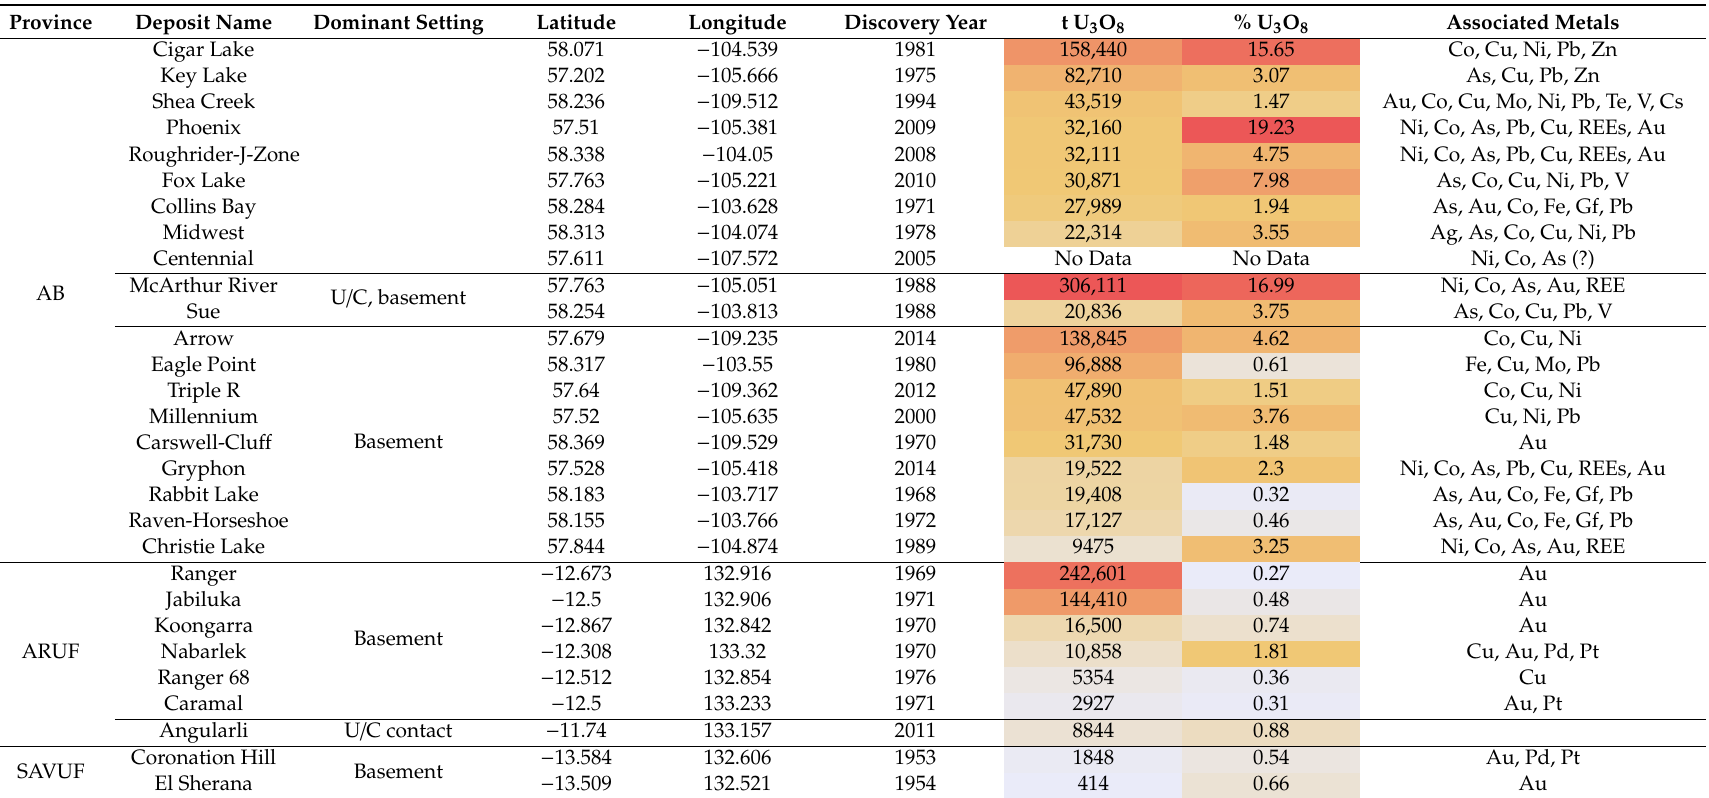
Table 1. Major unconformity-type uranium deposits of the Athabasca Basin (AB), Saskatchewan, Canada and Alligator Rivers (ARUF) and South Alligator Valley (SAVUF) uranium fields, NW McArthur Basin, Northern Territory, Australia. Sources: [2] (Annex Table 2.1), [25–28].